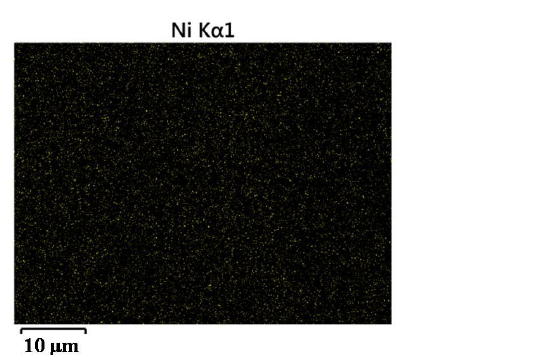
Figure 13. Surface scan of FeCrMnNi alloy after corrosion in 400 °C high temperature and high pressure water environment for 14 days.